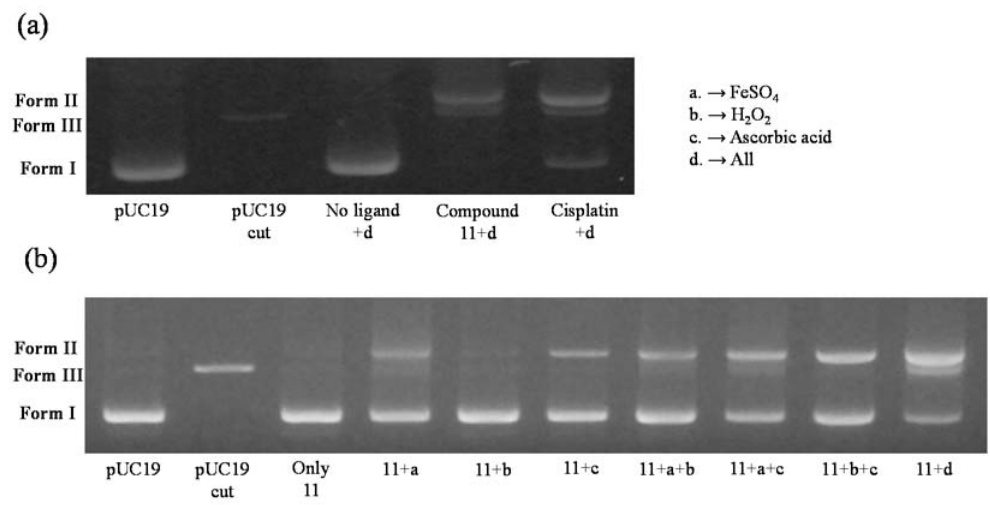
Figure 5. The DNA cleaving capability of the Fe(II) complexes of compound 11 and cisplatin in the presence of the iron (II) complex ( a ) and control experiments using compound 11 in the presence and absence of FeSO 4 , H 2 O 2 , and ascorbic acid ( b ). It was studied by the relaxation of the supercoiled pUC19 DNA and analyzed by agarose-gel